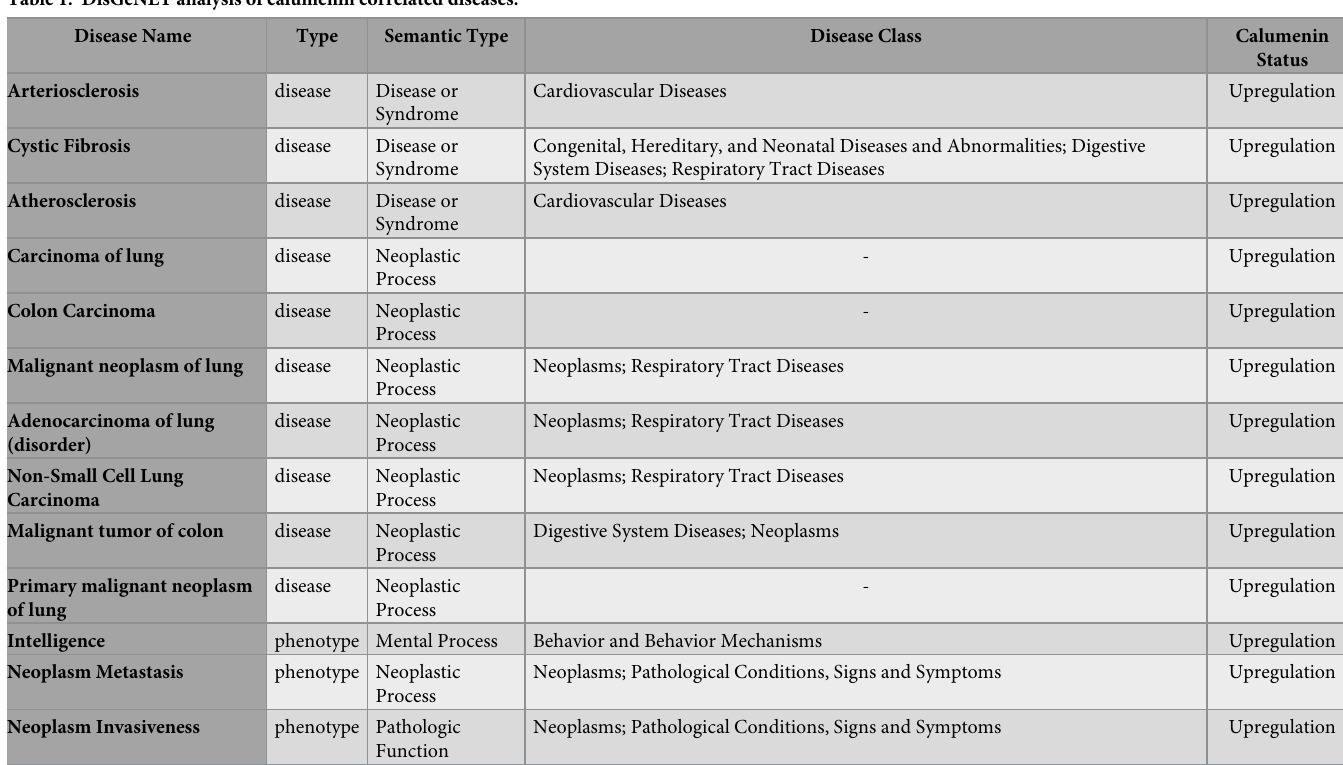
Table 1. DisGeNET analysis of calumenin correlated